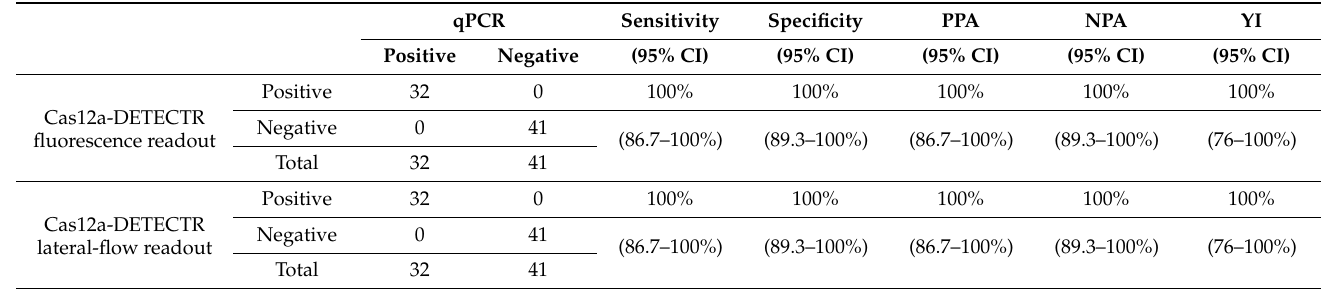
Table 1. Clinical validation of a DETECTR-based assay for the detection of HBV.